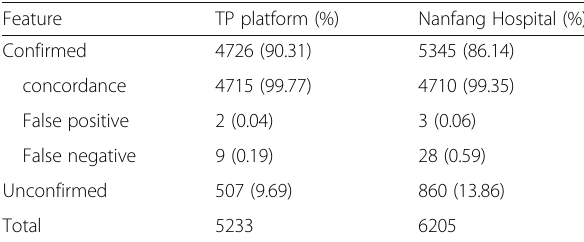
Table 2 Concordance data comparison between cases from the TP platform and from Nanfang Hospital Feature